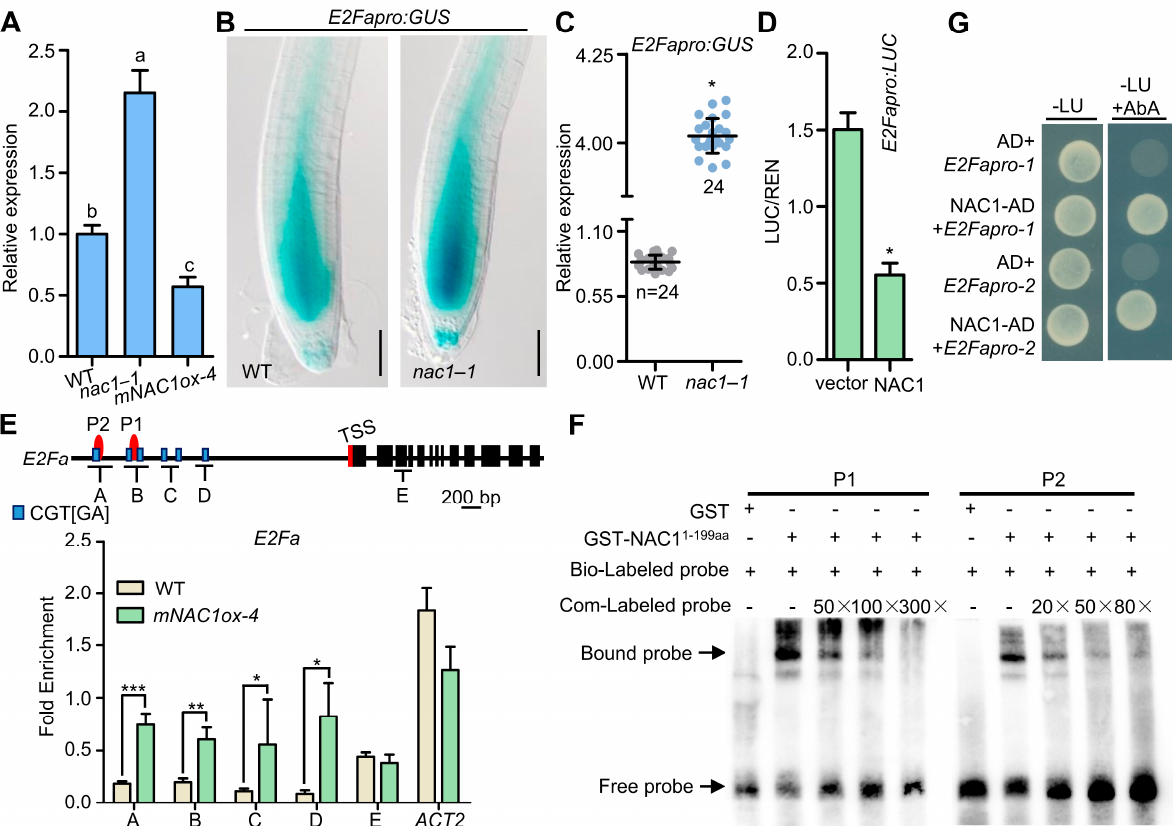
Figure 3. NAC1 directly binds to E2Fa promoter and represses its expression. ( A ) RT-qPCR analysis of E2Fa expression in WT, nac1 – 1 , and mNAC1ox - 4. Total RNA was extracted from primary root of 5 dpg seedlings. The expression level in seedlings was defined as “1”. Three biological replicates with three technical replicates for each biological replicate were performed with similar results. Data represent mean ± SE of three biological replicates. Different letters above bars indicate a significant difference (one-way ANOVA, Tukey’ multiple comparisons test, p < 0.05). ( B ) Expression of the E2Fapro:GUS in WT, nac1 – 1 roots. E2Fapro:GUS crossed with nac1 – 1 seedling. The seedlings were photographed at 5 dpg. Scale bar represents 50 µ m. ( C ) Statistical analysis of E2Fapro:GUS expression in ( B ). Data represent mean ± SD, n denotes the total number of scored samples. Individual values (black dots) are shown (Student’s t test, * p < 0.05). ( D ) NAC1 transrepresses the E2Fa promoter in Arabidopsis leaf protoplasts. The effector ( 35s::NAC1 ) and reporter ( E2Fapro:LUC ) constructs. The